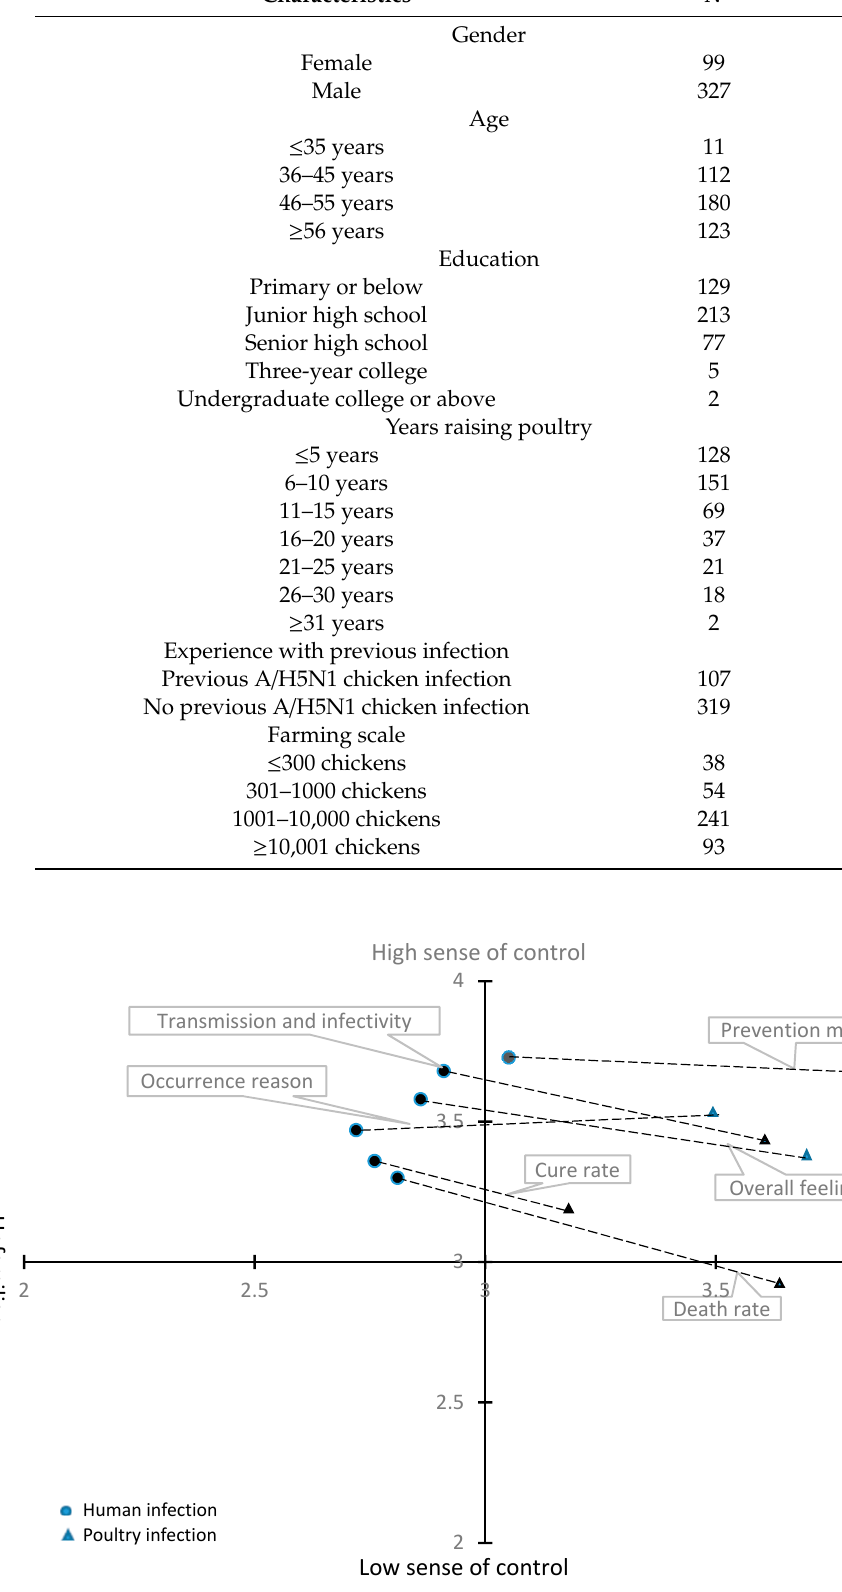
Figure 2. Spatial map of risk perception characteristics regarding human infection and poultry infection.